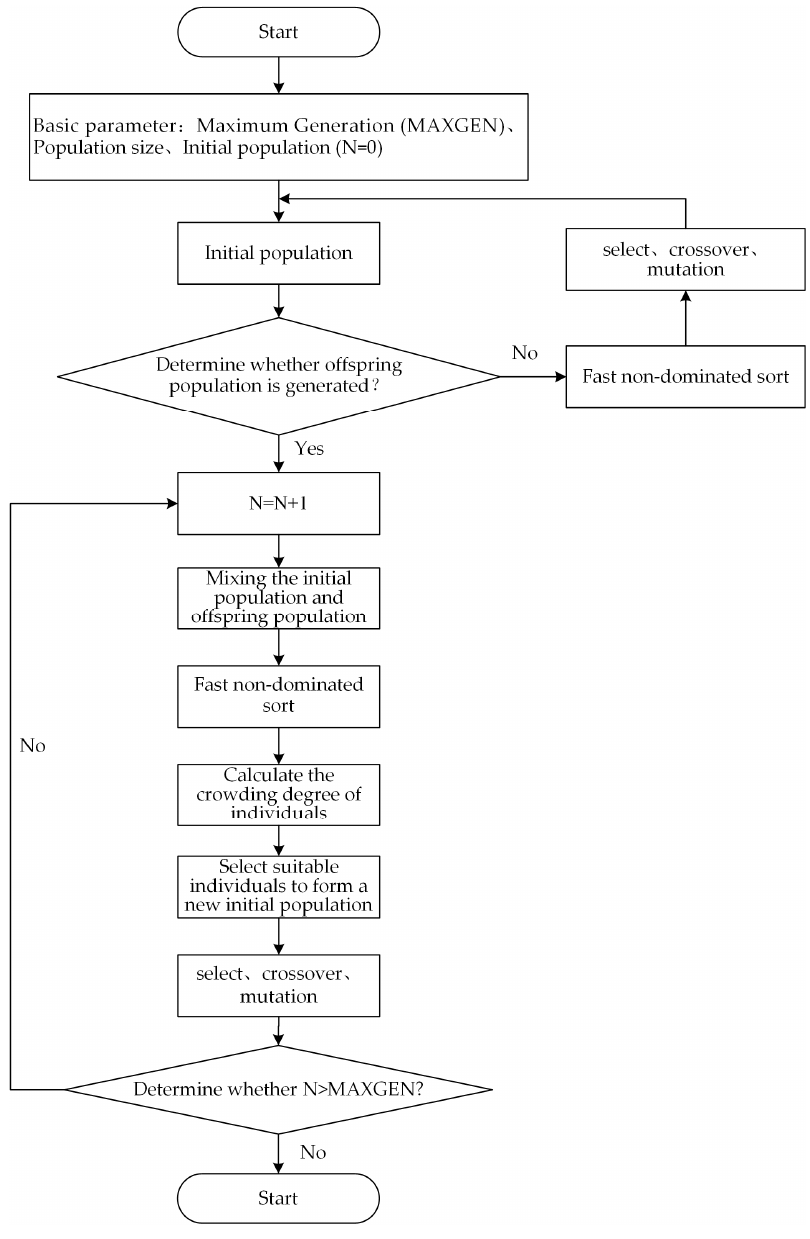
Figure 3. Calculation flow chart of NSGA-II.